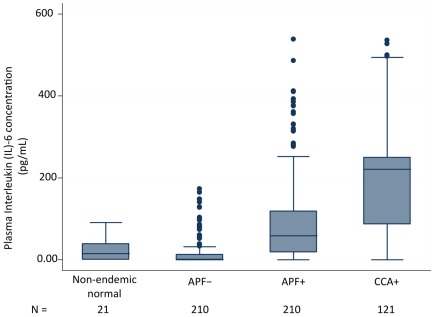
Plasma IL-6 levels are significantly elevated in individuals with Opisthorchis-induced APF and Opisthorchis-induced CCA.The distribution of plasma concentration of Interleukin (IL)-6) in picograms per milliliter is shown in boxplots by study group. The bottom and top of each box represent the 25th and 75th percentile (the lower and upper quartiles, respectively) of IL-6 concentration in plasma per group. The band near the middle of each box represents the median value of IL-6 concentration per group. The whiskers represent the minimum (bottom) and maximum (top) of IL-6 concentration per group.